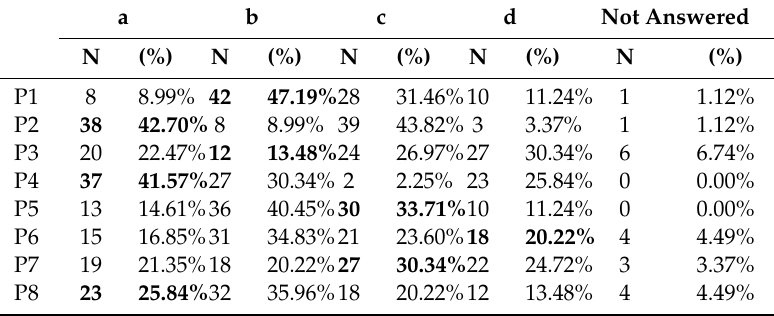
Table 4. Answers chosen to each one of the questions of the level test proposed. The right answer is marked in